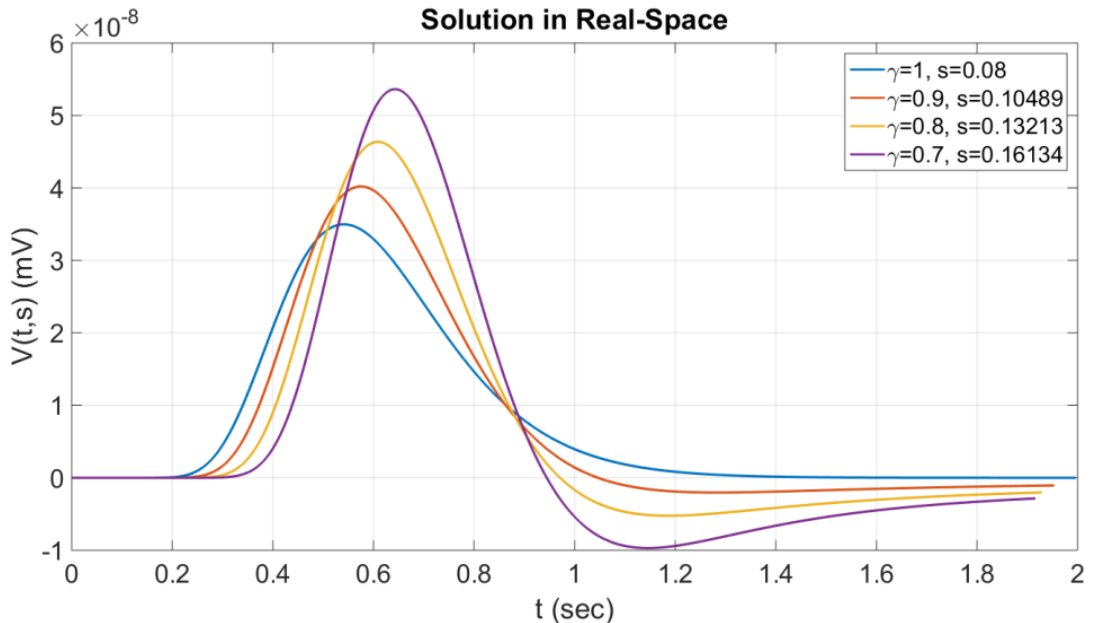
Figure 4. The voltage V(t,s) for various values of fractional order γ and corresponding values of s in real space (S = 0.08).